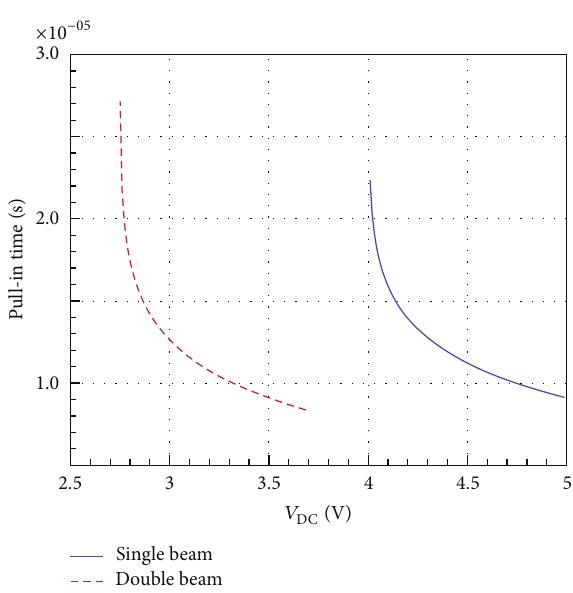
Figure 5: Influence of DC voltage on the pull-in time for simple and double beam microswitch designs.